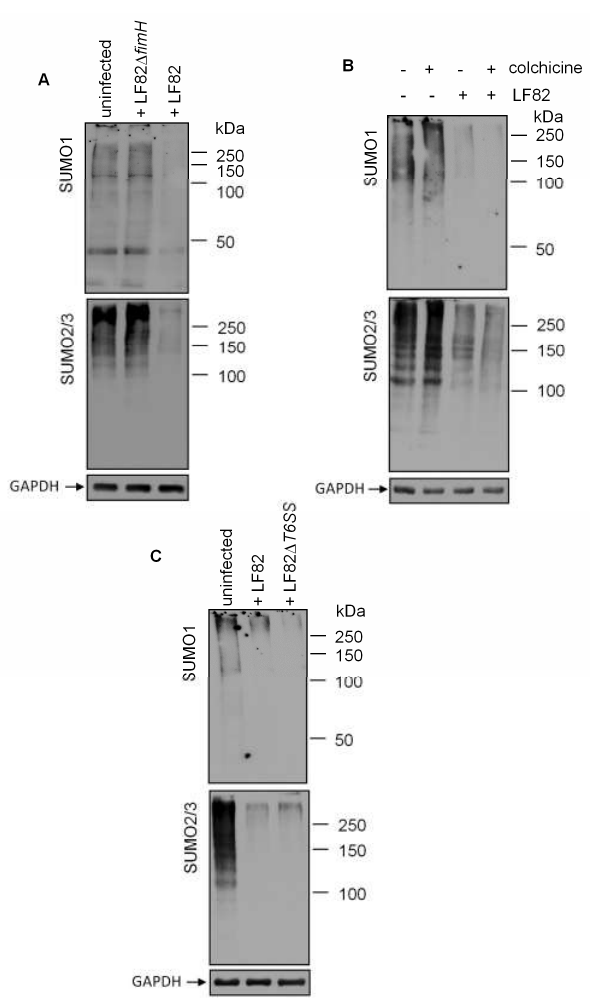
Figure 4. Adhesion of LF82 is required for deSUMOylation. ( A , C ) T84 cells were infected with wild-type AIEC LF82, LF82 ∆ fimH , or LF82 ∆ T6SS , and the SUMO-conjugated protein profile wild-type AIEC LF82, LF82Δ fimH , or LF82Δ T6SS , and the SUMO-conjugated protein profile was